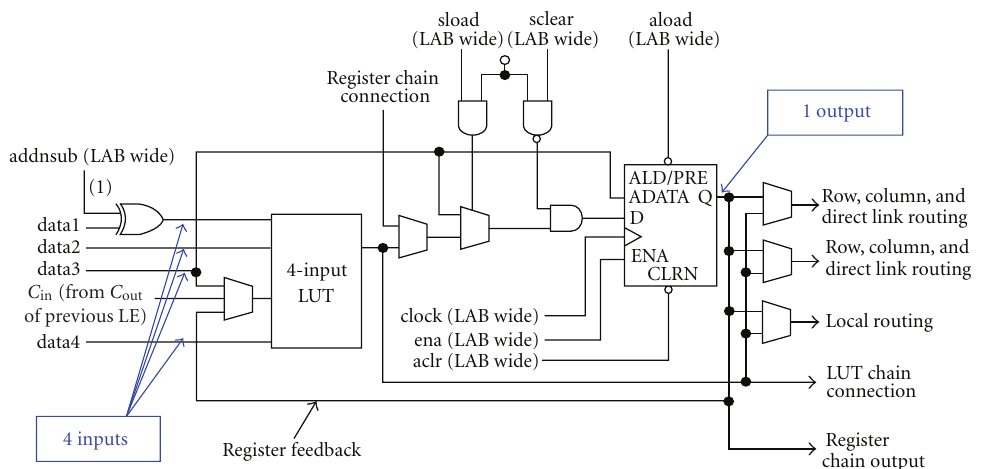
Figure 4: High-Level block diagram of a LuT, extracted from “Stratix Device Family Data Sheet, volume 1” [24].